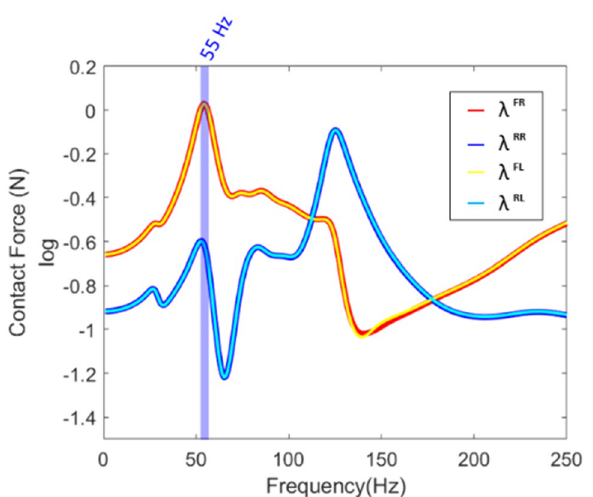
Figure 5. Contact forces (frequency domain).